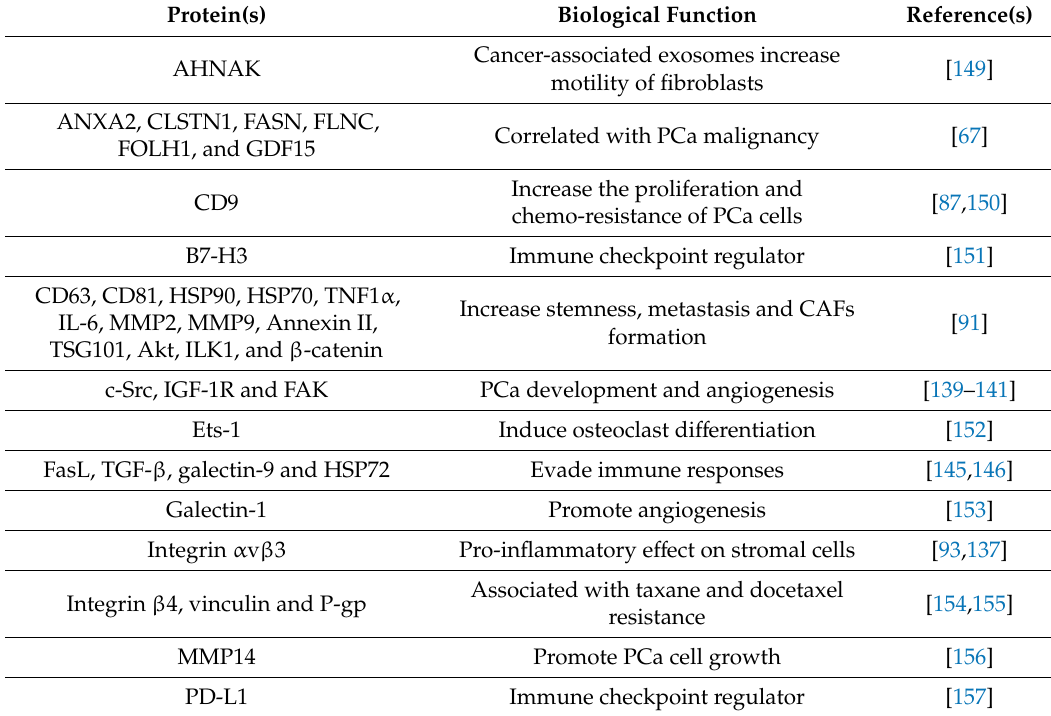
Table 1. Exosomes-associated cargo proteins and their functional relevance in Tumor microenvironment